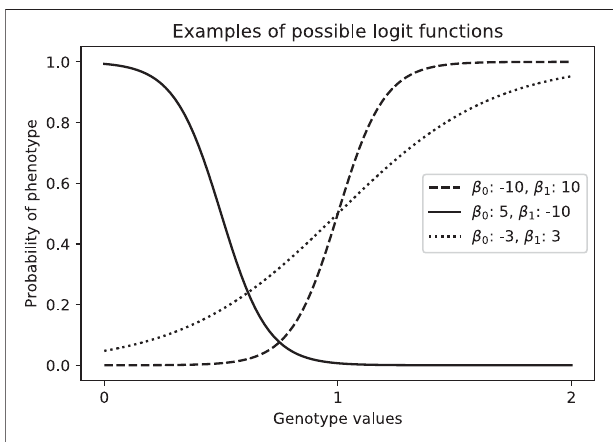
FIGURE 8 | Examples of estimated probability of phenotype given a genotypevalue,whichiscodednumericallyasthenumberof alternative alleles (aa (cid:1) 0, Aa (cid:1) 1, AA (cid:1)